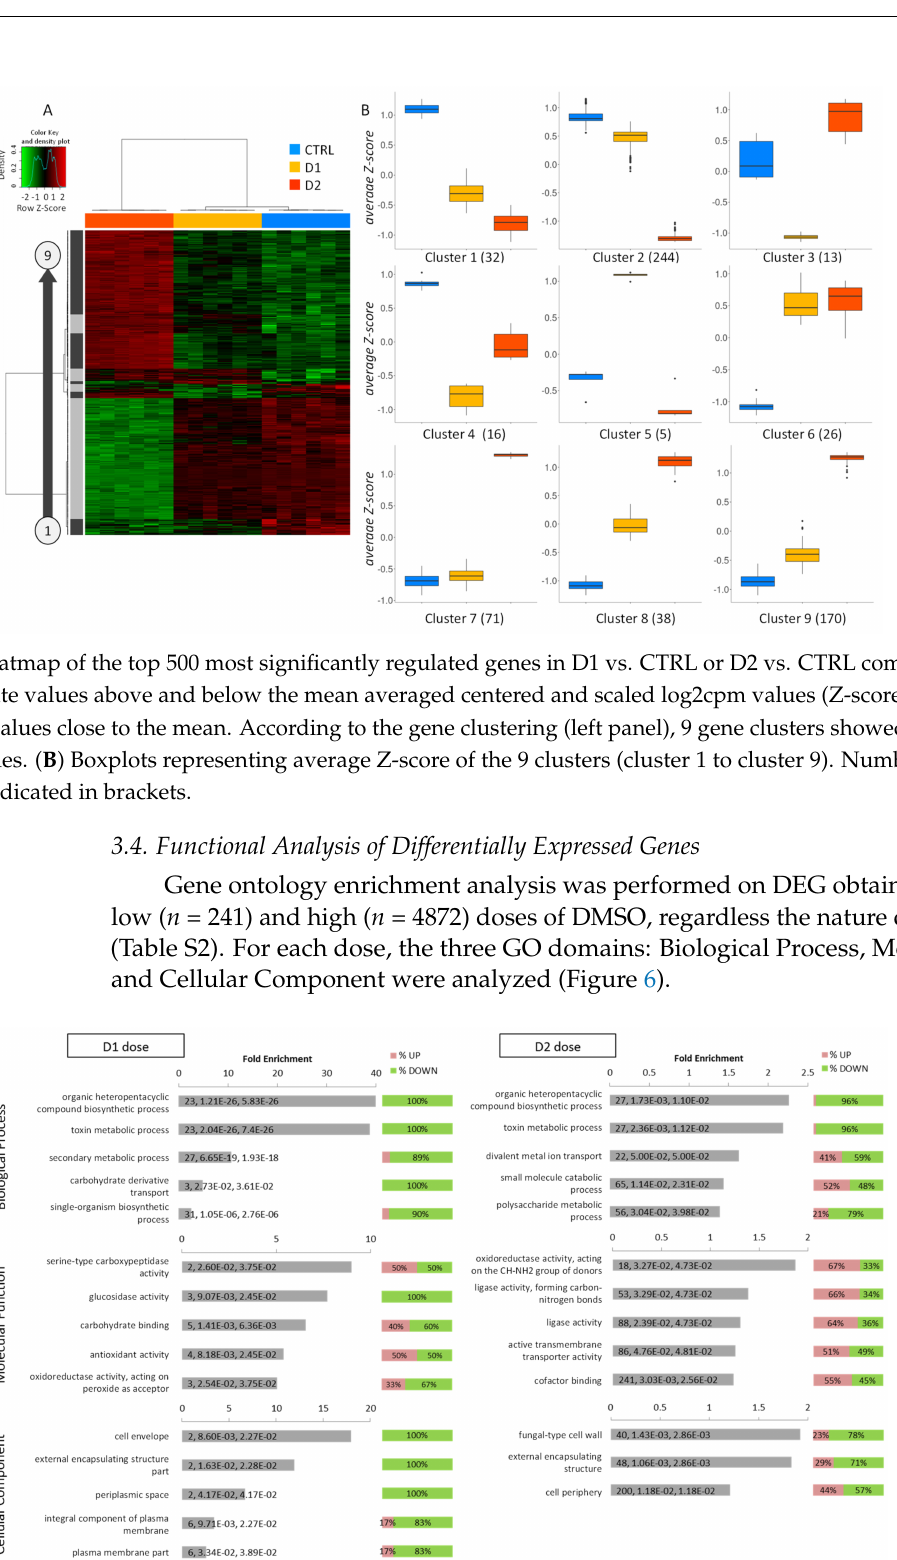
Figure 6. GO enrichment analysis of regulated genes by D1 and D2. Top 5 enriched GO categories according to the Fold Enrichment in Biological Process, Molecular Function and Cellular Component for each DMSO condition (D1 and D2). For each category, the label indicates the total number of regulated genes assigned to the specific GO category, the p -value and the adjusted p -value after Benjamini–Hochberg correction. The pink/green bars on the right of bar-plots show the percentage of up/down-regulated genes among each GO